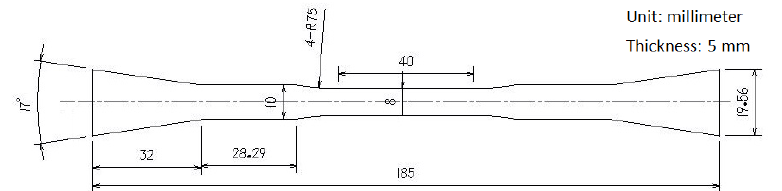
Figure 1. Sketch of the tensile test specimen.